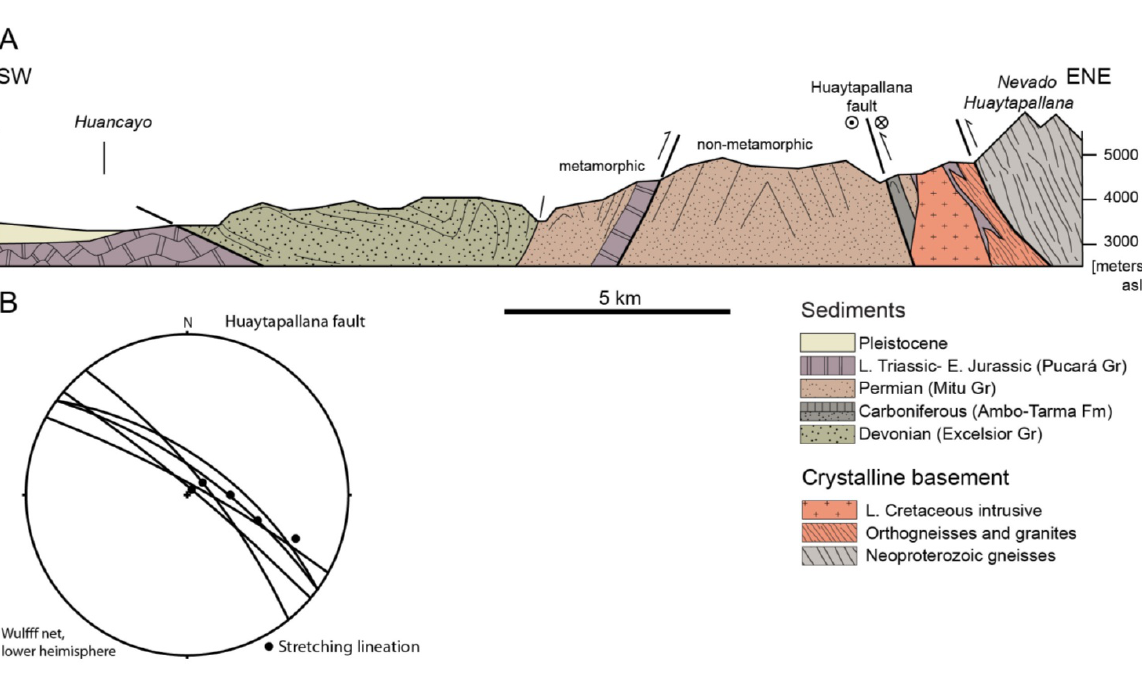
Figure 11. Structural style in the western part of the Eastern Cordillera near Abra Huaytapallana (see Figure 7 for location). ( A ) Cross-section showing folding within the Paleozoic sediments and the Huaytapallana fault juxtaposing Neoproterozoic crystalline basement to the Paleozoic sediments. The Abra Huaytapallana fault is a steep reverse fault with a left-lateral strike slip component; ( B ) Stereoplot of foliation planes (great circles) and stretching lineations indicating strike-slip with thrust component. The northeastern block moved up, placing crystalline basement next to Paleozoic sediments [as shown in ( A